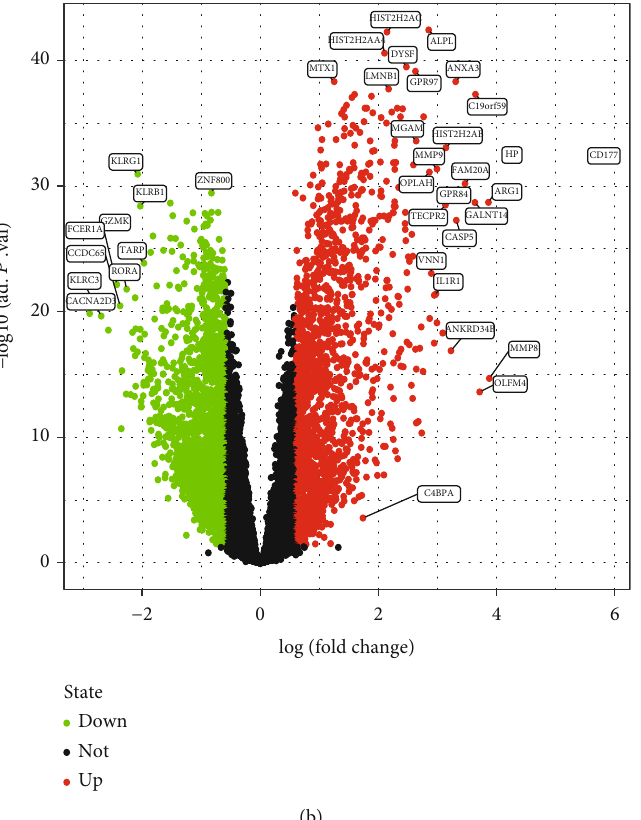
Figure 1: Di ff erentially expressed genes between Kawasaki disease and normal samples. (a) Heatmap of top 100 up and top 100 down DEGs (Con was normal control group, and Treat was Kawasaki disease group). (b) Volcano plot of